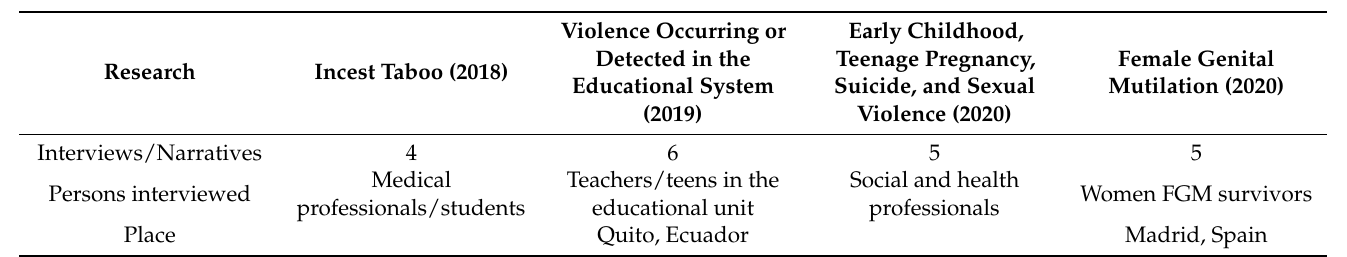
Table 1. Research fieldwork.